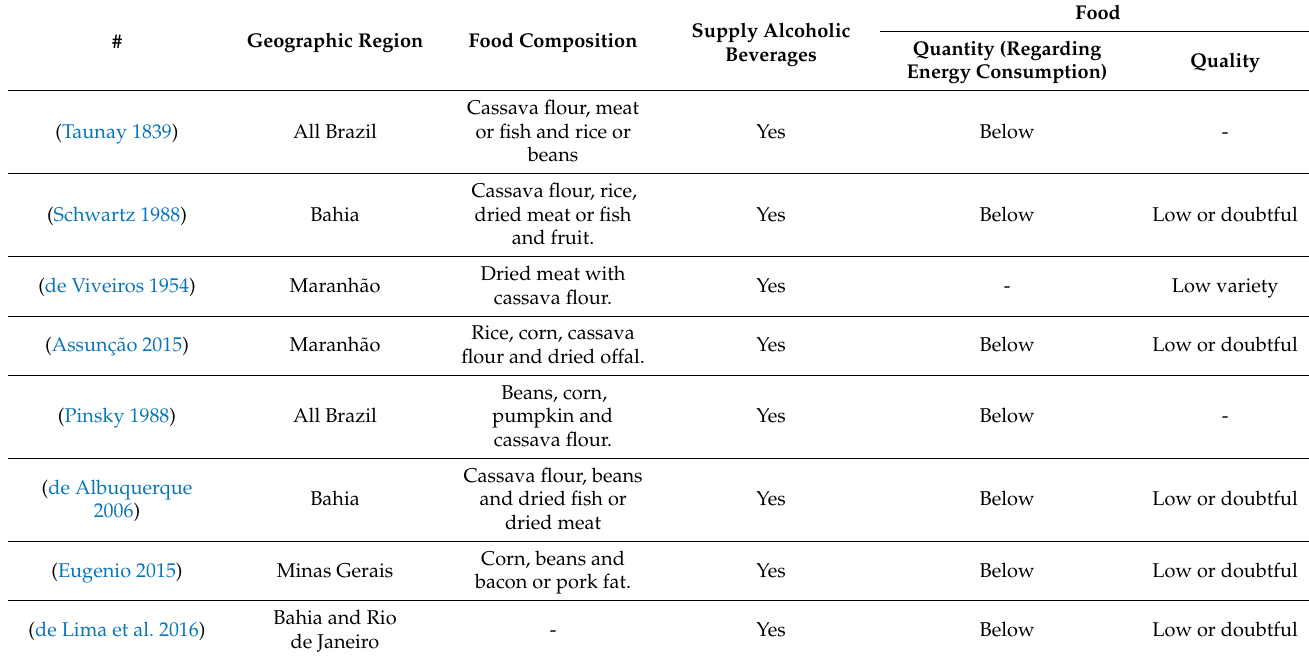
Table 2. Description of food and alcohol